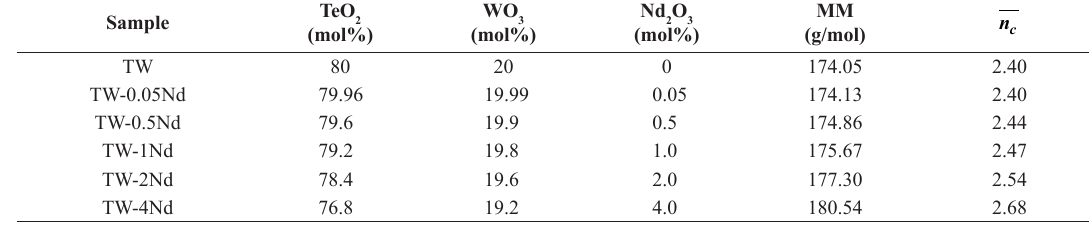
Table 1. Nominal composition (mol%), mass molar (g/mol), and average crosslink density of the Nd 3+ -doped TW glasses.